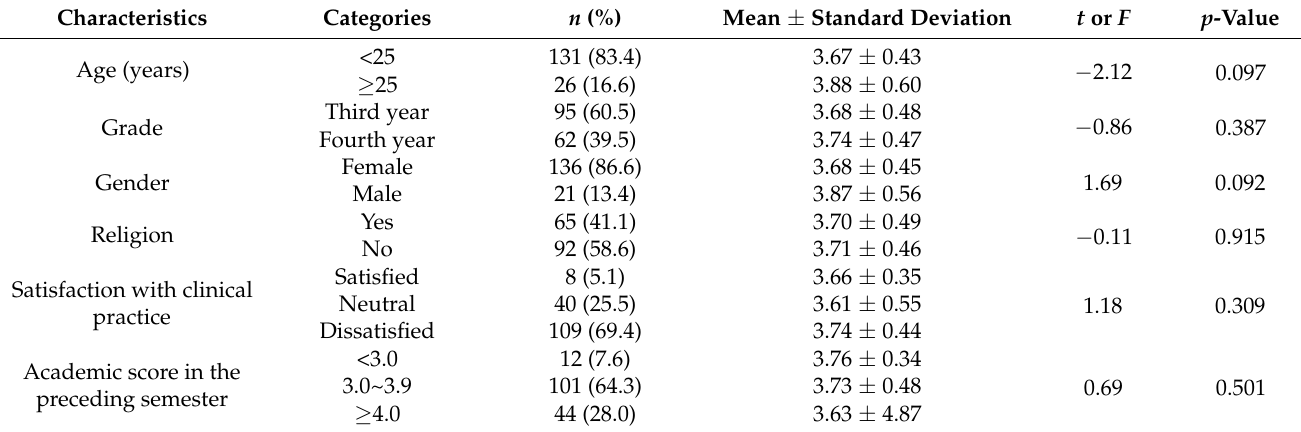
Table 1. Difference in the PCC competence according to general characteristics ( n = 157).